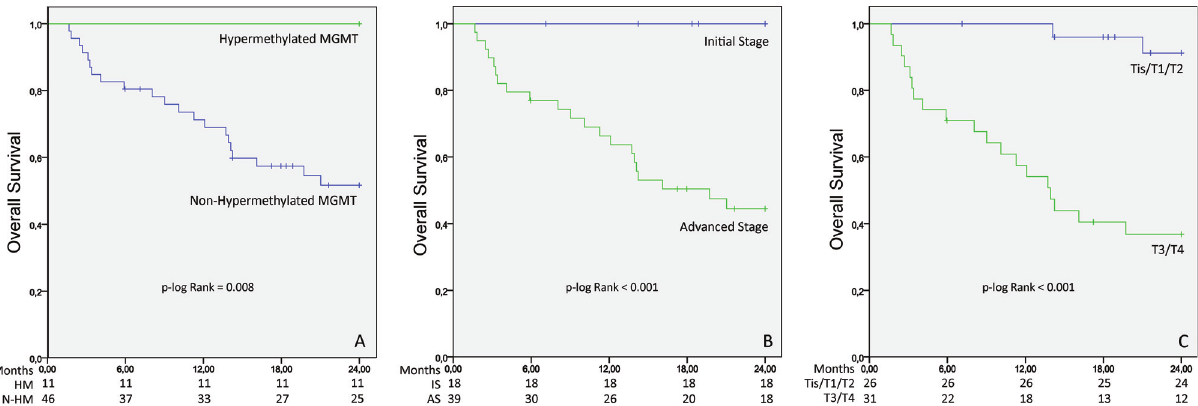
Figure 1 - Kaplan Meier estimates of overall survival among patients with oral and oropharyngeal squamous cell carcinoma according to MGMT hypermethylation, Tumor Stage and Tumor